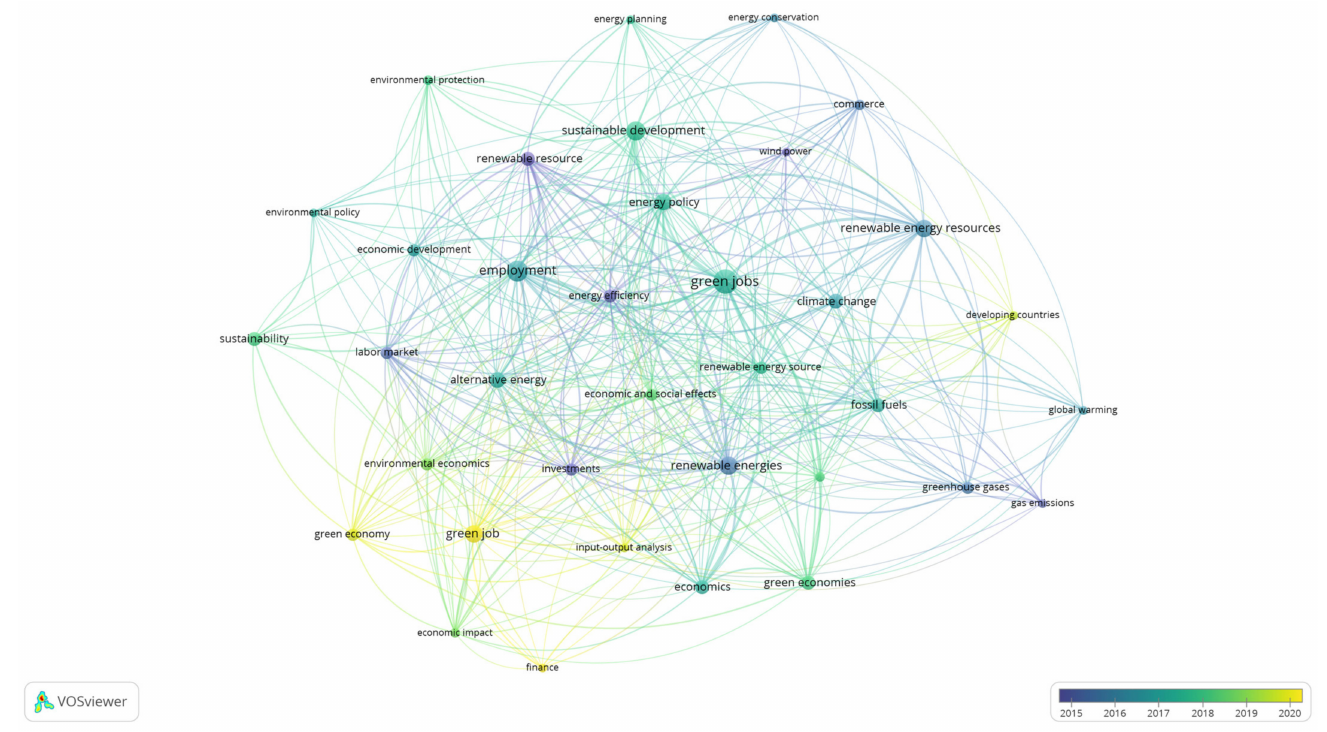
Figure 4. Overlay map of the indexed keyword co-occurrences. Source: Authors’ elaboration in VOSviewer software (1.6.18 version).